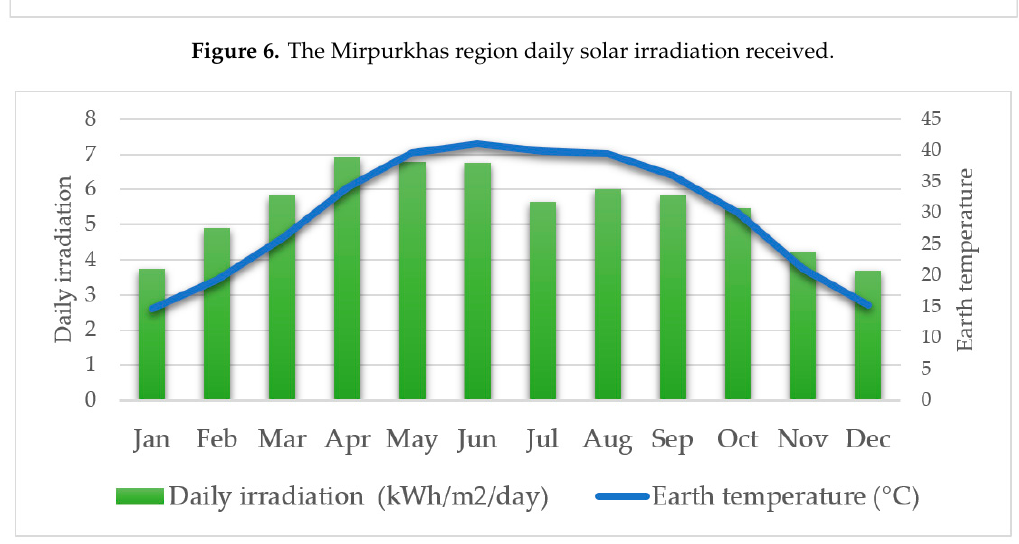
Figure 7. The Kambar region daily solar irradiation received.